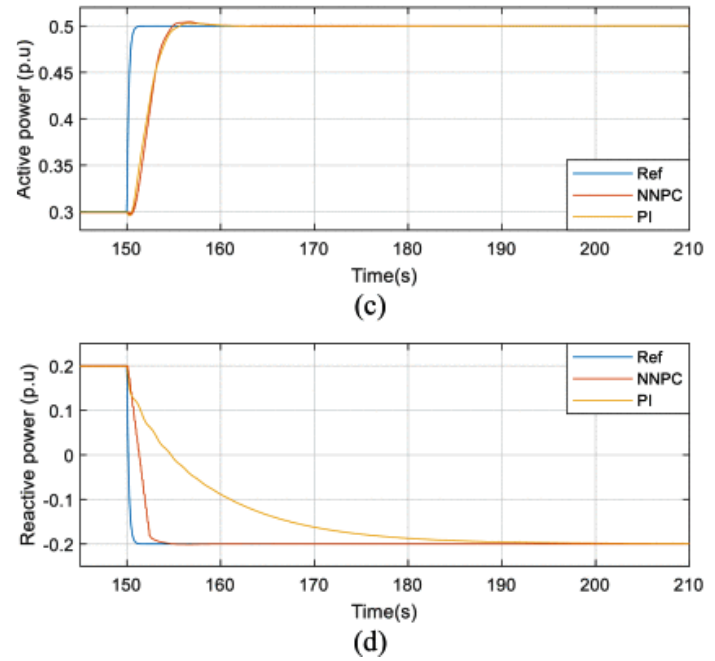
VSG and PI control. ( a ) Active power. ( b ) Re- −